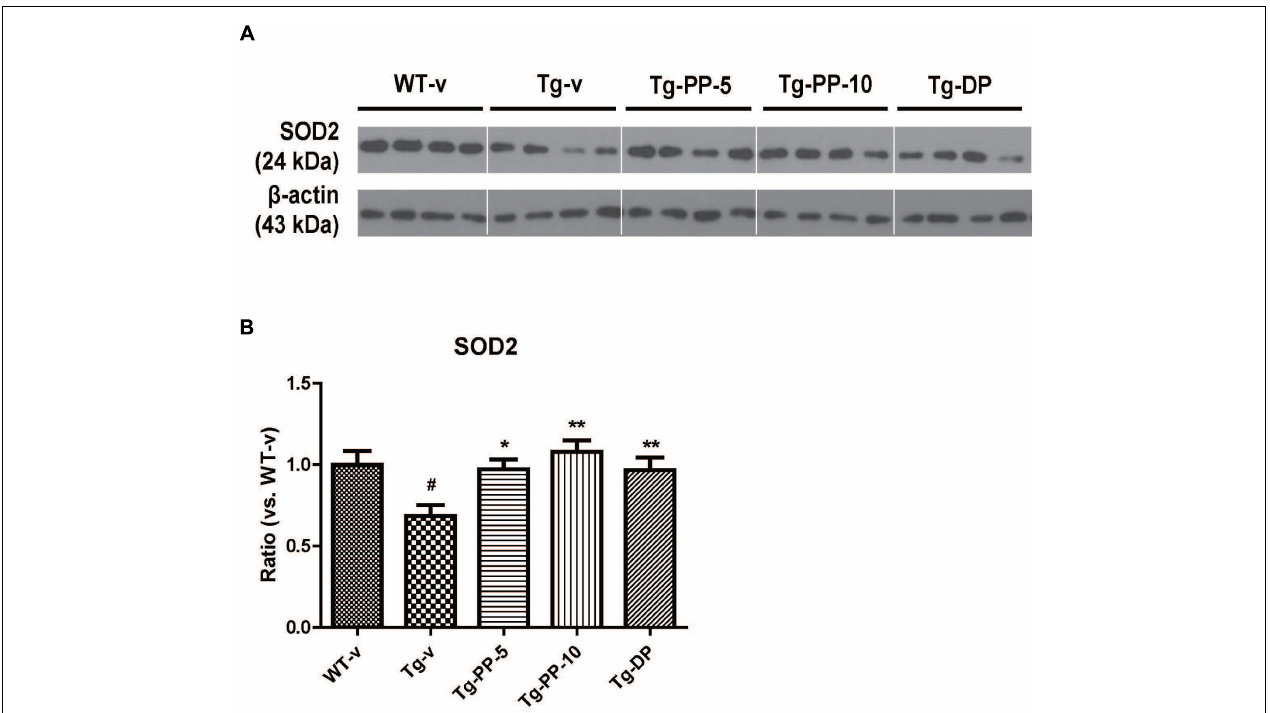
FIGURE 5 | PSM-04 increased the expression of SOD-2 in the brain of 5xFAD mice. Representative Western blot demonstrating protein expression levels of SOD-2 in the hippocampus of each group. (A) Representative blot showing that SOD-2 protein levels increased in the hippocampal tissue lysates of PSM-04-treated Tg mice compared with those of the non-treated Tg mice. (B) The relative SOD-2 protein levels were shown as a ratio versus to the control (Tg-v). The statistical analyses were performed by one-way ANOVA, and data are presented as the means ± SEM. # p < 0.05 vs. WT-v. ∗ p < 0.01 and ∗∗ p < 0.01 vs. Tg-v. WT-v ( n = 8); WT-PP-5 ( n = 9); Tg-v ( n = 7); Tg-PP-5 ( n = 6); Tg-PP-10 ( n = 6); Tg-DP ( n =